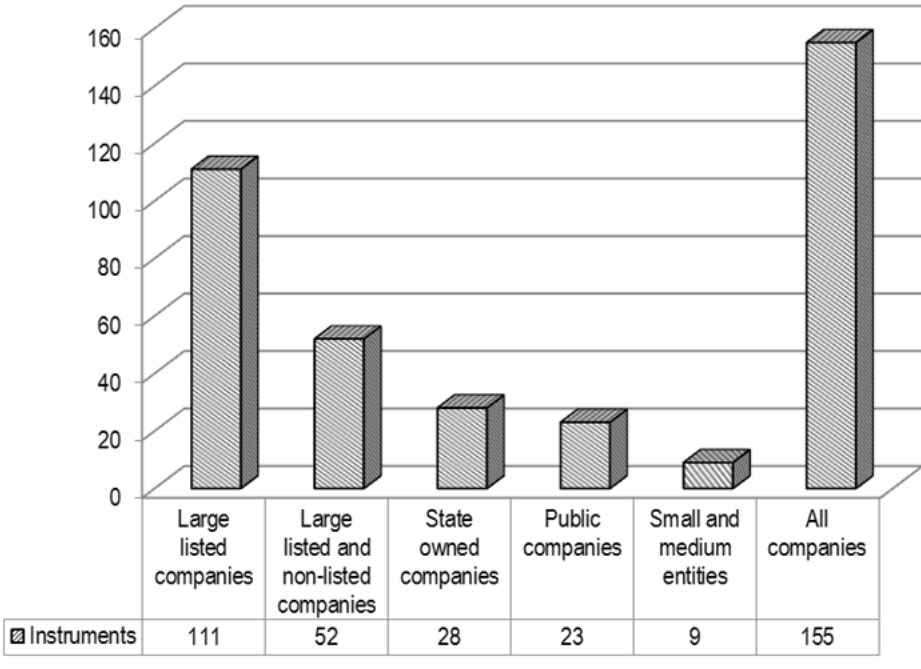
Fig. 1. Instruments of standardization and regulation in SR by the company types in 2016 Source: based on Carrots and Sticks (2016).